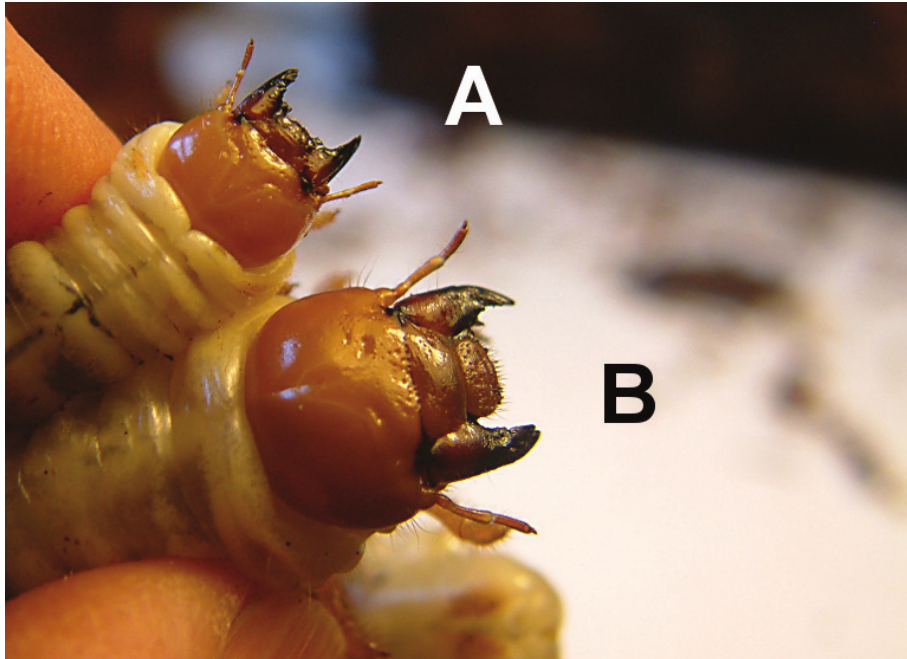
Figure 4. Head capsule, mandibles and relative size of lucanid larvae: A Dorcus parallelipipedus B Lu- canus cervus (photo by M.